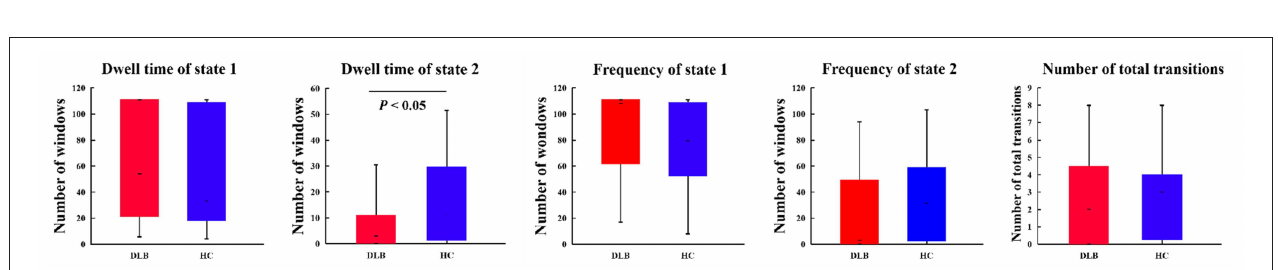
Frontiers in Neurology |